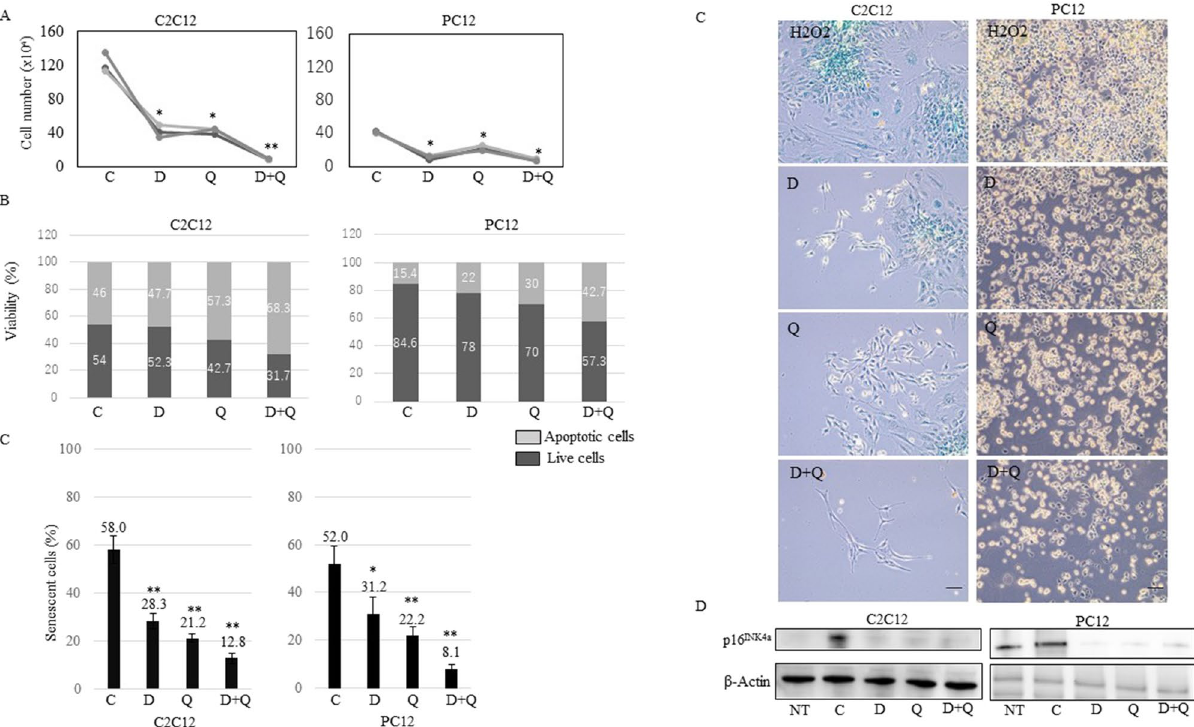
Figure 3. ( A,B) Cell number (× 10 4 ) and viability (%) of H 2 O 2 control vehicle (C; 0.1% ethanol), D (50 nM), Q (10 μM), or D + Q (50 nM + 10 μM)-treated C2C12 and PC12 cells at 13 days after H 2 O 2 treatment. Dark gray is live cells and light gray is apoptotic cells. ( C) Percentage (%) of SABG-positive cells and images of H 2 O 2 control vehicle (C; 0.1% ethanol), D (50 nM), Q (10 μM), or D + Q (50 nM + 10 μM)-treated C2C12 and PC12 cells at 13 days after H 2 O 2 treatment. Scale bar, 100 μm. ( D) Immunoblotting of non-treated (NT), H 2 O 2 control vehicle (C; 0.1% ethanol), D (50 nM), Q (10 μM), or D + Q (50 nM + 10 μM)-treated C2C12 and PC12 cells using p16 Ink4a and β-actin antibody. Cropped blots were used in this figure. The display of cropped gels was arranged by ChemiDoc image Lab software (Bio-Rad Laboratories). Original full-length blots are presented in Supplementary Fig. 2. SABG; senescence-associated beta-galactosidase, NT; non-treated, C; control, D; dasatinib, Q; quercetin. ** p < 0.01, * p < 0.05, two-tailed Student’s